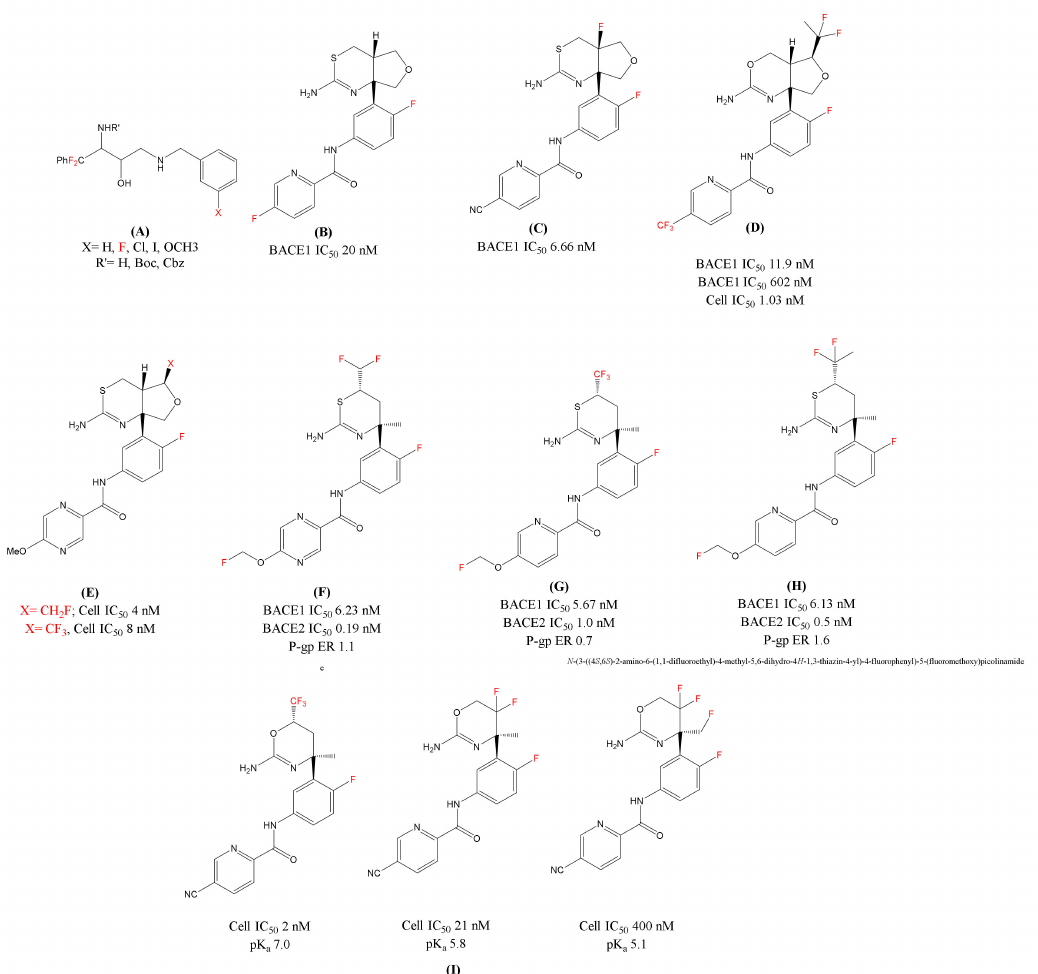
Figure 3. Chemical structures of the fluorine-decorated BACE1 inhibitors ( A ) Fluorinated ethanolamines; ( B )LY-2886721(N-(3-((4aS,7aR)-2-amino-4a,5-dihydro-4H-furo[3,4-d][1,3] thiazin-7a(7H)-yl)-4-fluorophenyl)-5-fluoropicolinamide); ( C ) Fluorinated analogue of LY-2886721(N-(3-((4aR,7aR)-2-amino- 4a-fluoro-4a,5-dihydro-4H-furo[3,4-d][1,3]thiazin-7a(7H)-yl)-4- fluorophenyl)-5-cyanopicolinamide); ( D ) Lilly’s Fluorinated Inhibitor (N-(3-((4aR,5S,7aR)-2-amino-5-(1,1-difluoroethyl)-4a,5-dihydro-4H-furo[3,4-d][1,3]oxazin-7a(7H)-yl)-4 -fluorophenyl)-5-(trifluoromethyl)picolinamide); ( E ): Eisai’s BACE1 inhibitor [1,3] thiazine series Fluoro(methyl) analogues; F, G and H) Shingoi and Janssen’s organofluorine substituted BACE1 inhibitors; ( F ) N-(3-((4S,6S)-2-amino-6-(difluoromethyl)-4-methyl-5,6-dihydro-4H-1,3-thiazin-4-yl)-4- fluorophenyl)-5-(fluoromethoxy)pyrazine-2-carboxamide; ( G ) N-(3-((4S,6S)-2-amino-4-methyl-6- (trifluoromethyl)-5,6-dihydro-4H-1,3-thiazin-4-yl)-4-fluorophenyl)-5-(fluoromethoxy)picolinamide; ( H ) N-(3-((4S,6S)-2-amino-6-(1,1-difluoroethyl)-4-methyl-5,6-dihydro-4H-1,3-thiazin-4-yl)-4- fluorophenyl)-5-(fluoromethoxy)picolinamide); and ( I ) Roche’s Fluorinated 1,3-oxazines inhibitors.In red color are represented fluorine molecules (F) and trifluoromethyl groups (CF 3